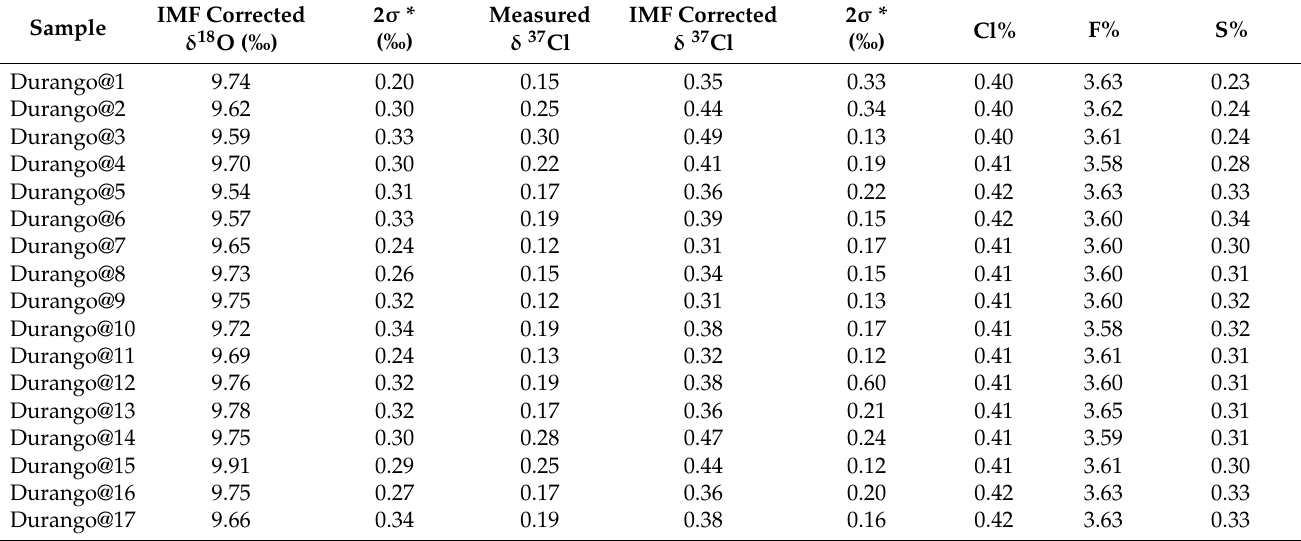
Table 5. Calibrated data from session 2.